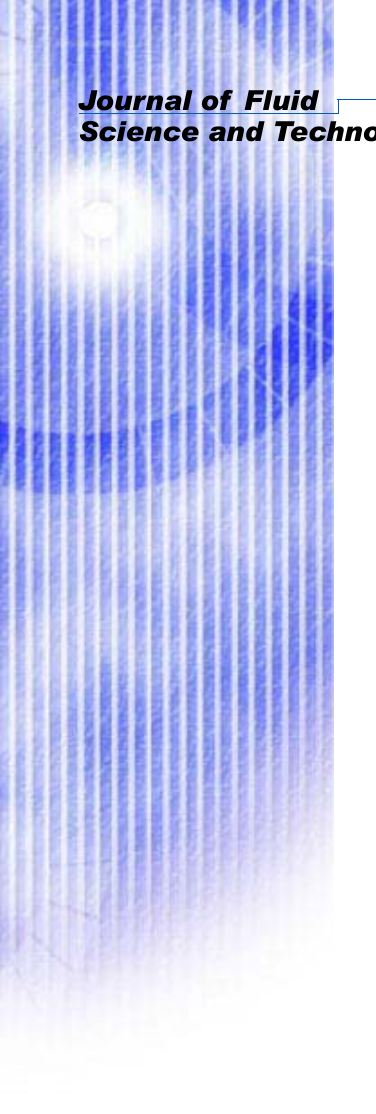
Fig. 6 Heat flux curve at S3